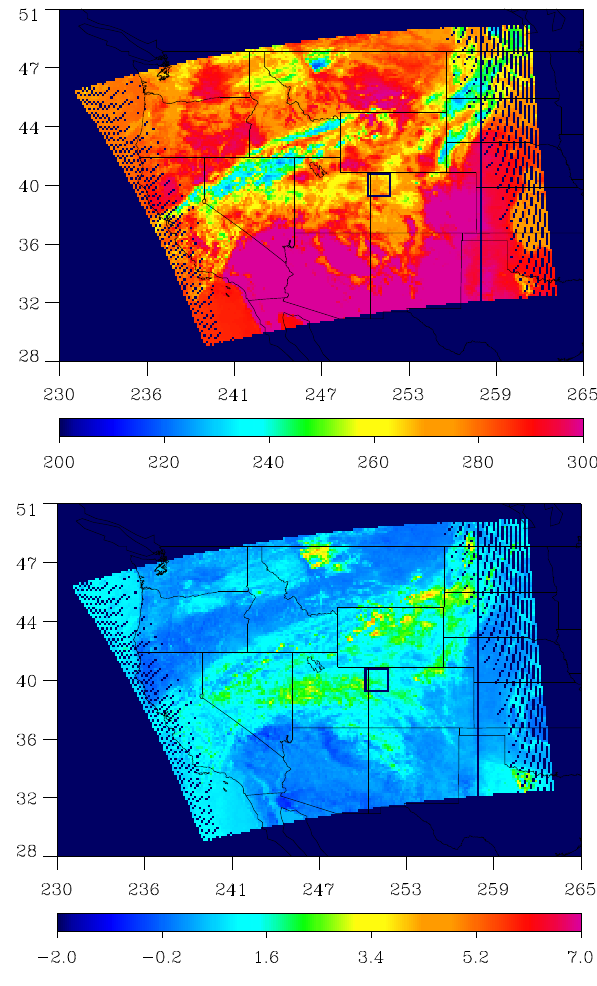
Fig. 3. Figure shows the MODIS 11.0µm brightness temperature (top panel) and the 11.0µm minus 12.0µm BTD (bottom panel) for the 17 March 2030 GMT overpass. The SPEC 25 Learjet was located in thin cirrus in western Colorado as indicated by the low BTD areas in the black box. Low values of BTD for these cirrus suggest clouds dominated by large crystals for this